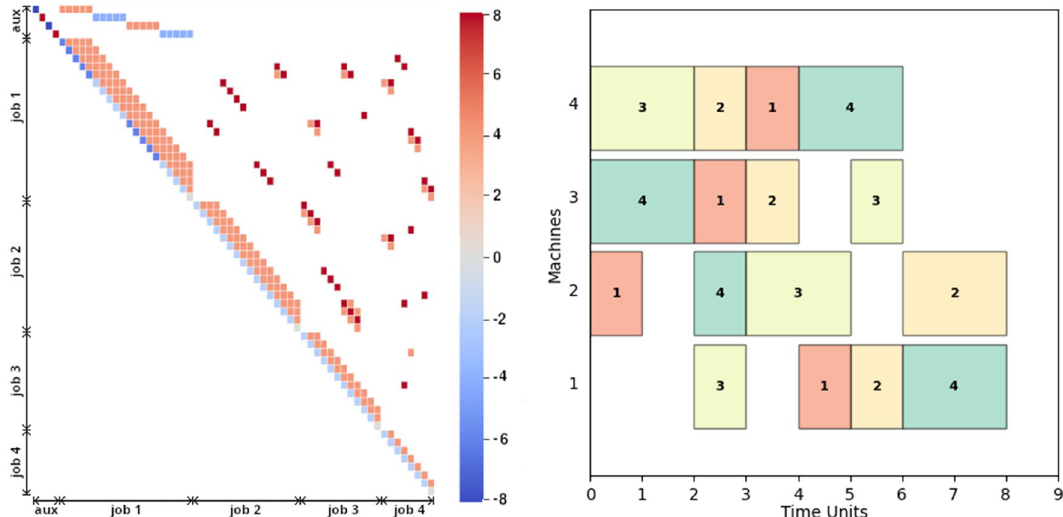
Figure 5. Visualization of a JSSP instance with unknown optimal solution. ( Left ), the QUBO matrix represented as heatmap, where each square represents a variable (operation per unit time). The color scale follows the bias and variance of each variable coupling. ( Right ) a Gannt diagram of a possible schedule obtained with